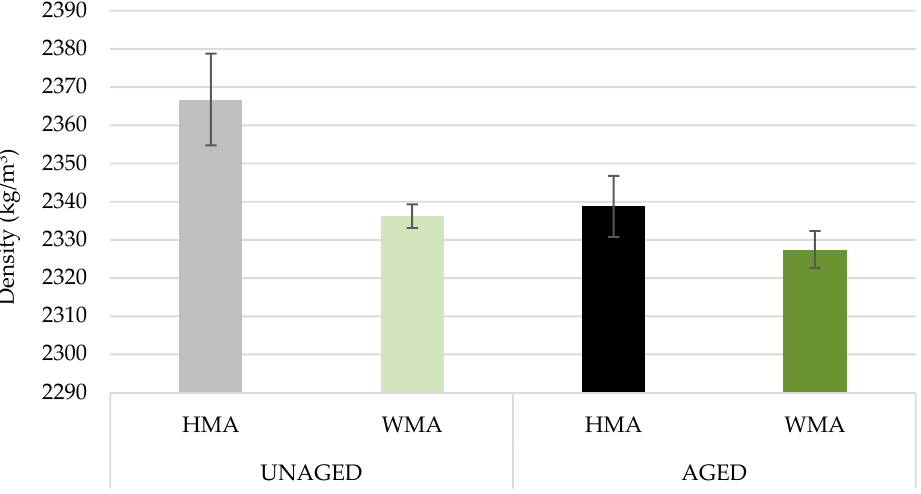
Figure 4. Average bulk densities of wheel tracking slabs.